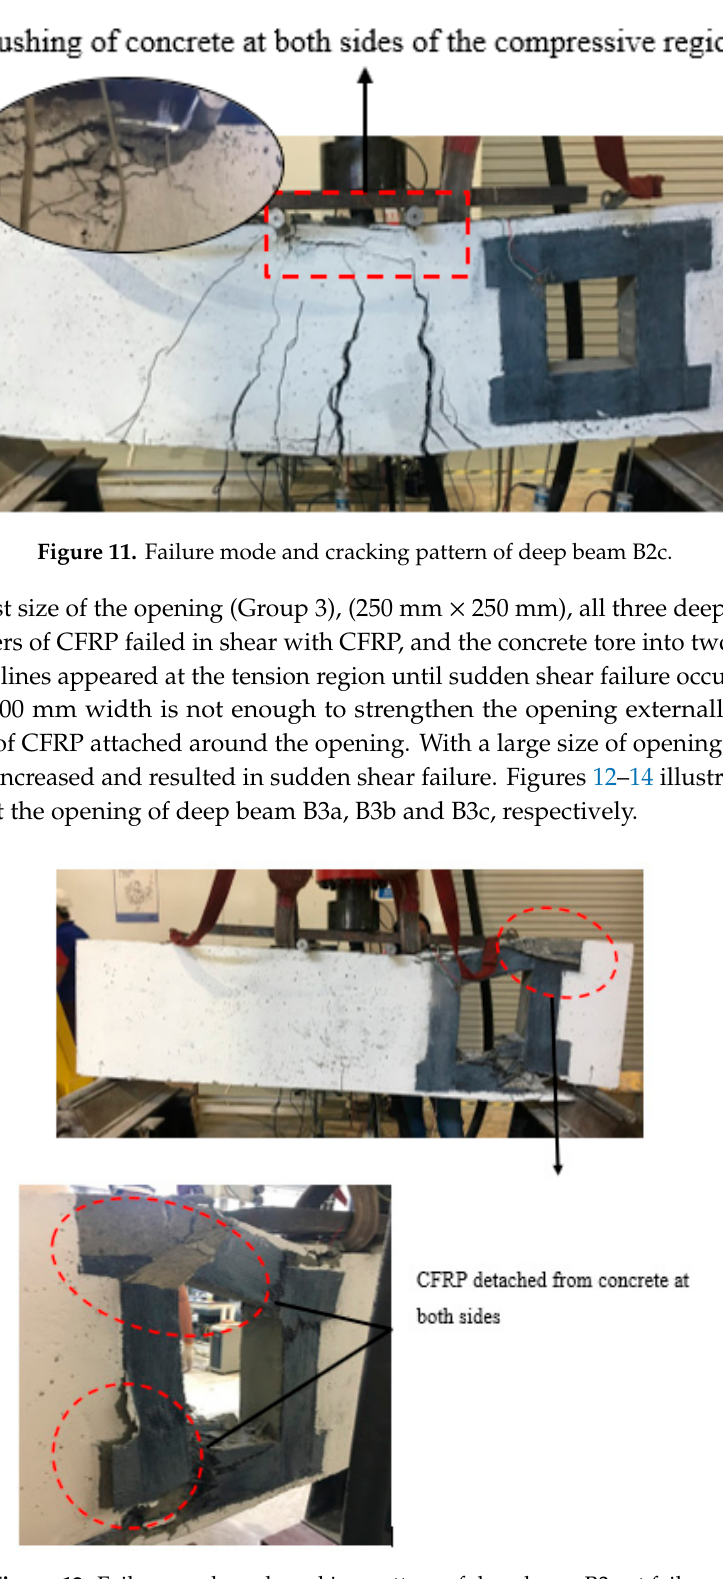
Figure 12. Failure mode and cracking pattern of deep beam B3a at failure.